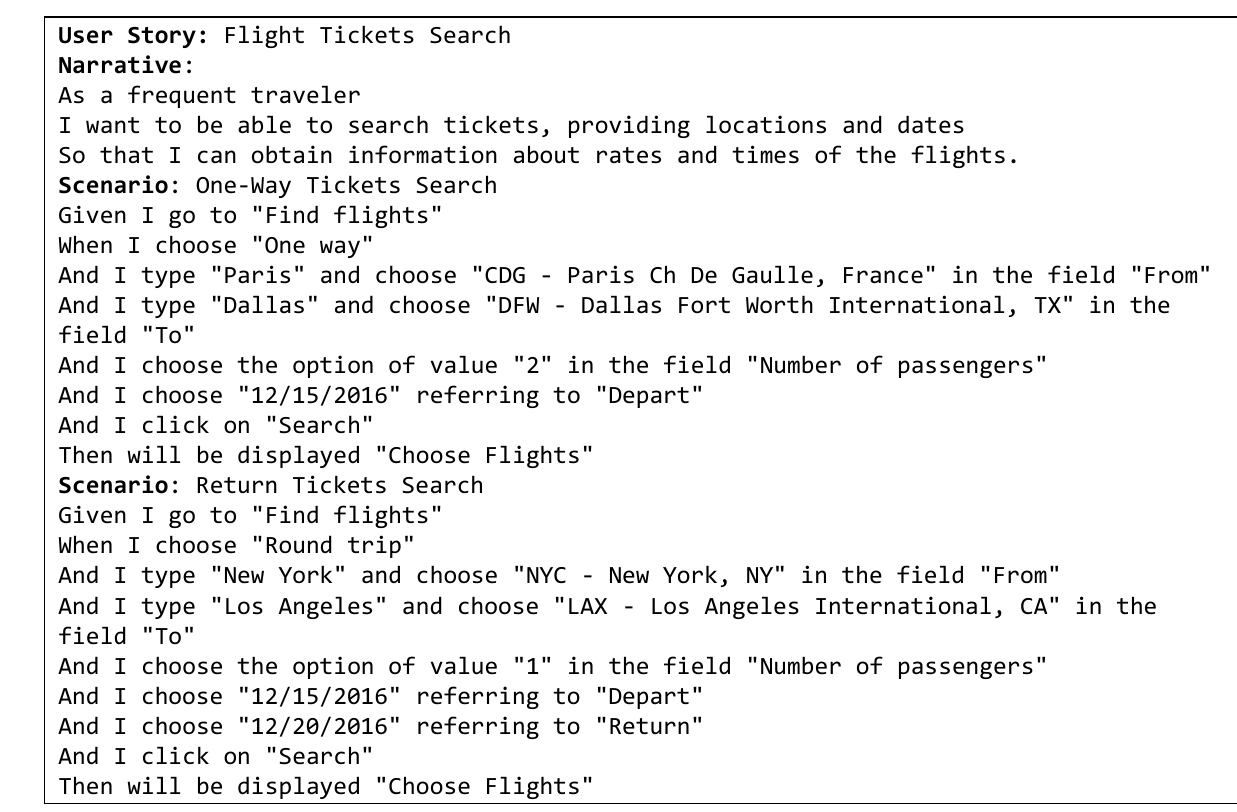
Figure 10. User Story for Flight Ticket Search formatted for the testing